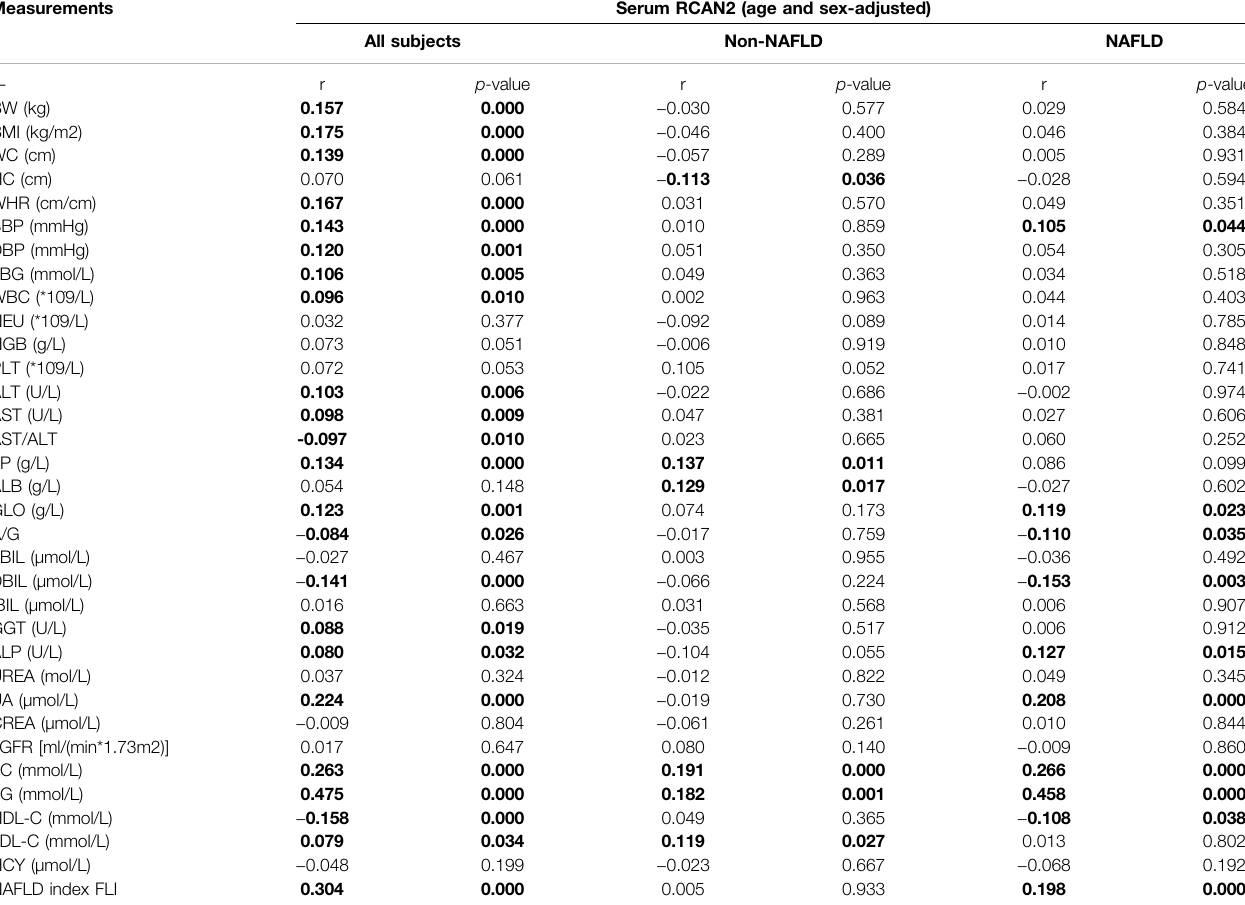
TABLE 3 | Partial correlation between serum RCAN2 levels and other parameters. Measurements Serum RCAN2 (age and sex-adjusted) All